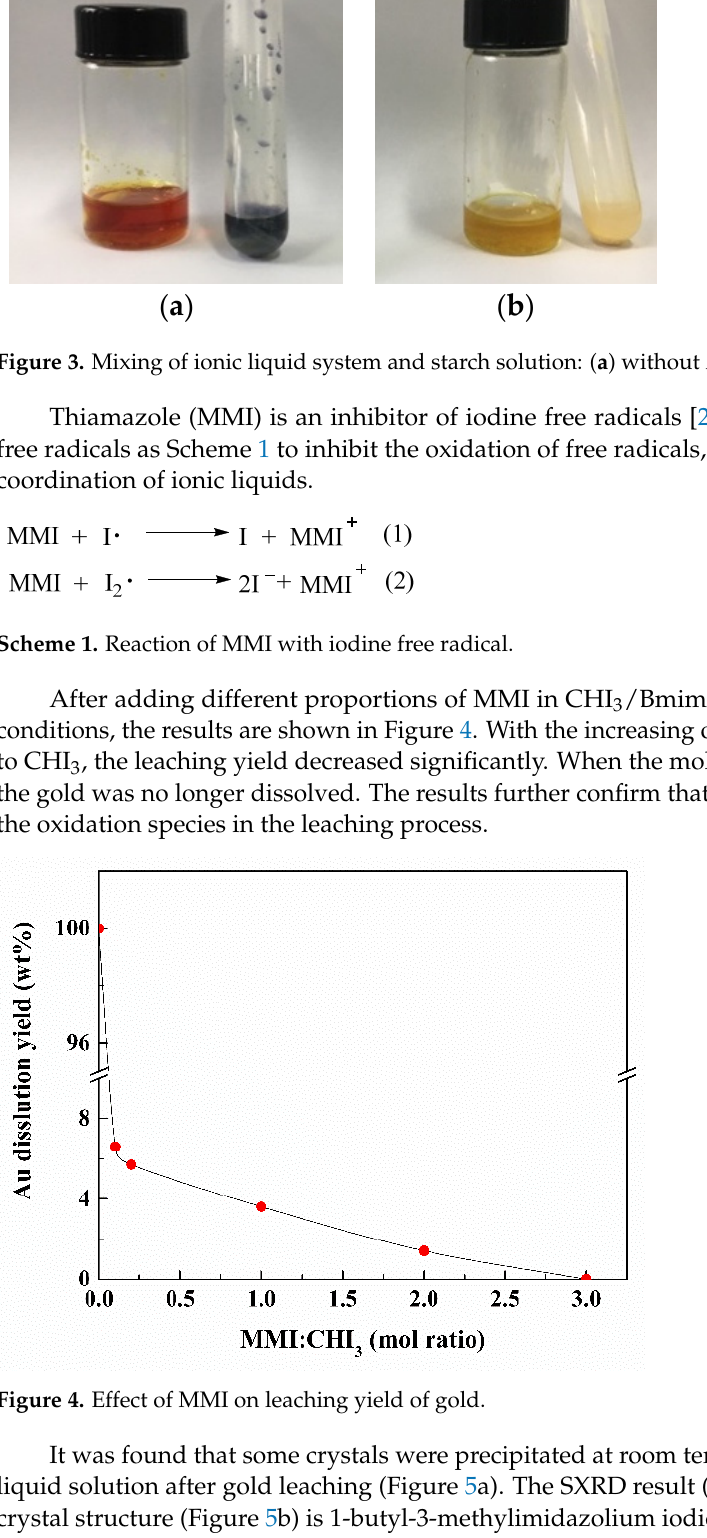
Figure 4. Effect of MMI on leaching yield of gold.